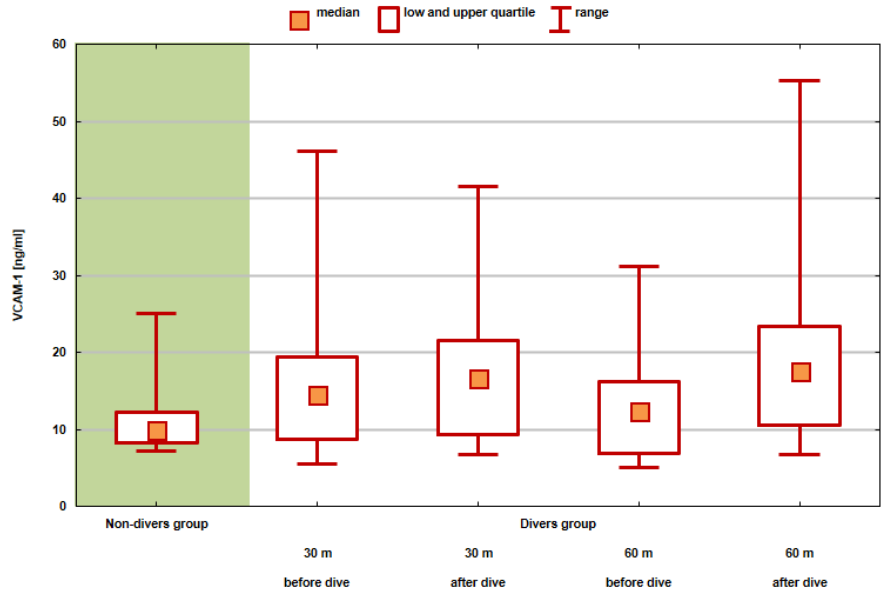
Figure 5. Values of position statistics of VCAM-1 distribution in the compared groups and test series. Table 7. Descriptive statistics characterizing the distribution of leukocytes and hemoglobin counts in individual tests, showing the significance of changes between tests completed before and after exposure. M Me SD Min.